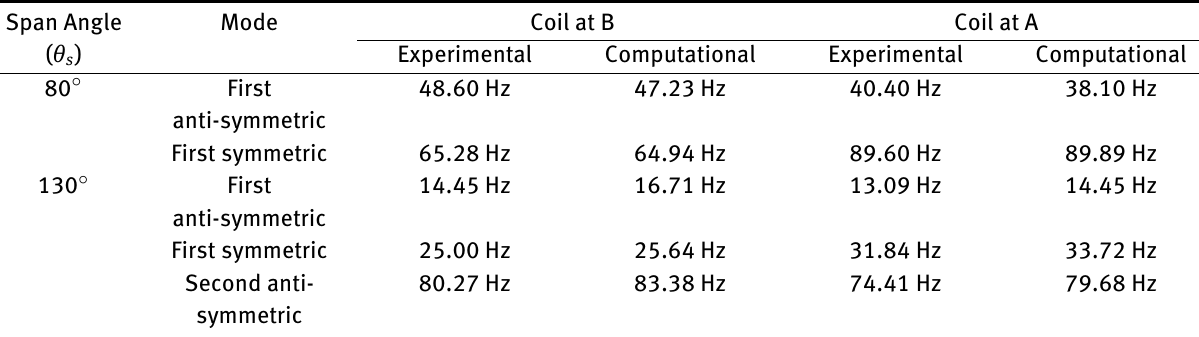
Table 1: First two linear free vibration frequencies of beams. Span Angle Mode Coil at B Coil at A ( θ s ) Experimental Computational Experimental Computational 80